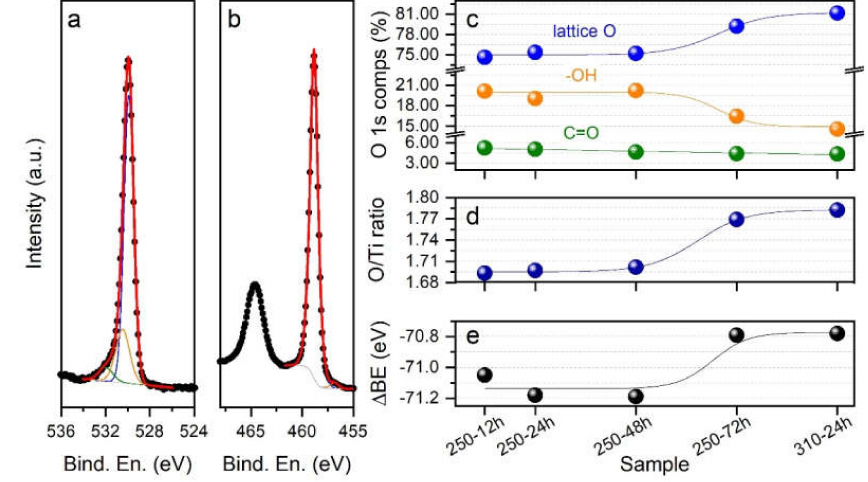
Figure 5. Results of the X-ray photoelectron spectroscopy (XPS) investigation. ( a , b ) XPS data collected over the O 1s and Ti 2p regions, respectively, on the A12h sample. The results of the best fitting procedure are also reported; ( c ) markers show the relative atomic concentrations of the O 1s components in the five analyzed samples, as obtained from the decomposition process. Lines are shown as a guide for the eye; ( d ) markers show the values of the O / Ti ratio, as obtained from the quantitative analysis of the XPS data. Here only the O 1s component assigned to lattice oxygen has been considered. The blue line is shown as a guide for the eye; ( e ) markers report the binding energy distance between the main O 1s component (i.e., lattice O) and the main Ti 2p peak (due to Ti(IV) species) for the five analyzed samples. The black line is shown as a guide for the